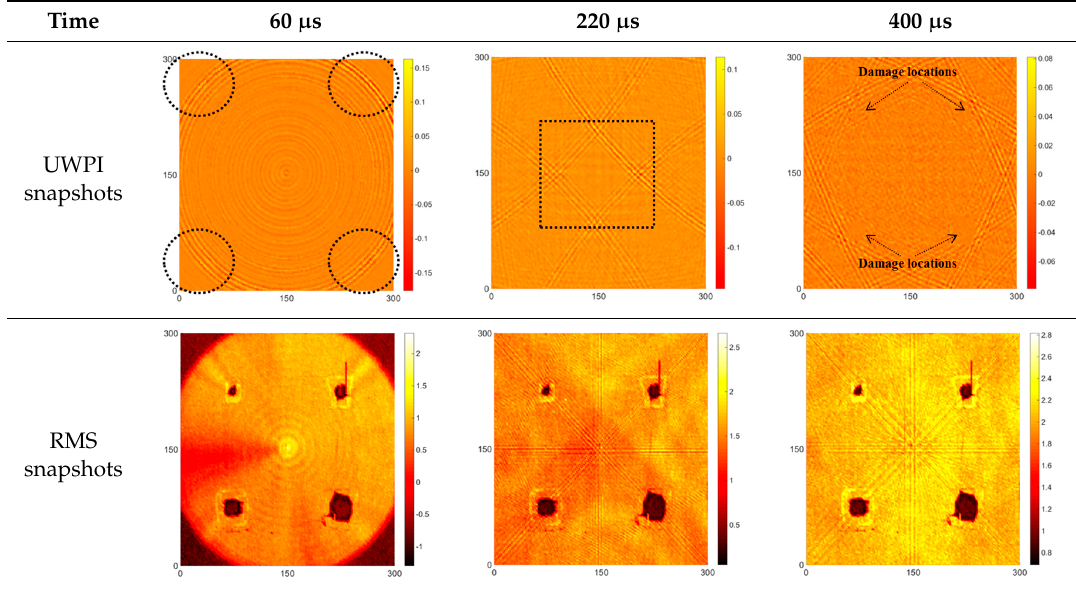
Table 6. UWPI and RMS snapshots of the front side of Specimen 2 at 60 μ s, 220 μ s, and 400 μ s (the unit of x and y axis: mm).